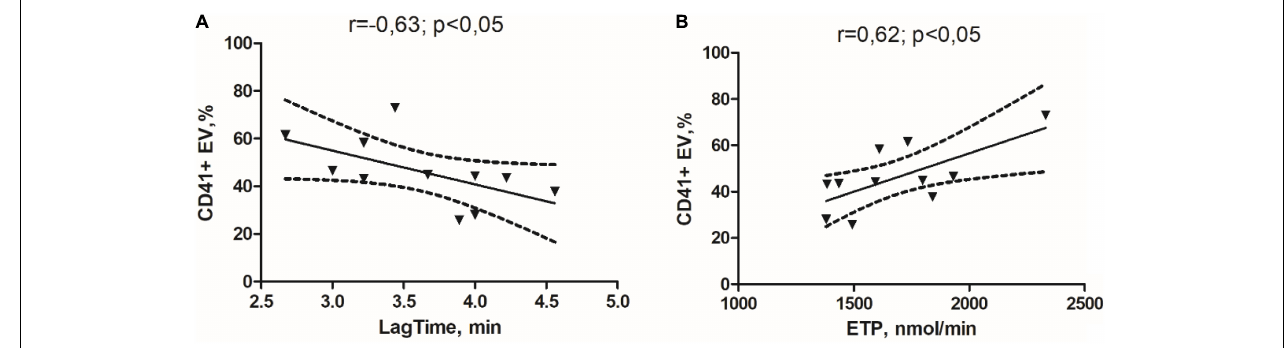
FIGURE 1 | Correlation links between the initiation time of coagulation in the study of thrombin generation test (TGT) and the percentage of the CD41 + EVs (A) and endogenous thrombin potential in the study of TGT and percentage of the CD41 + EVs in the glioma group (B) .